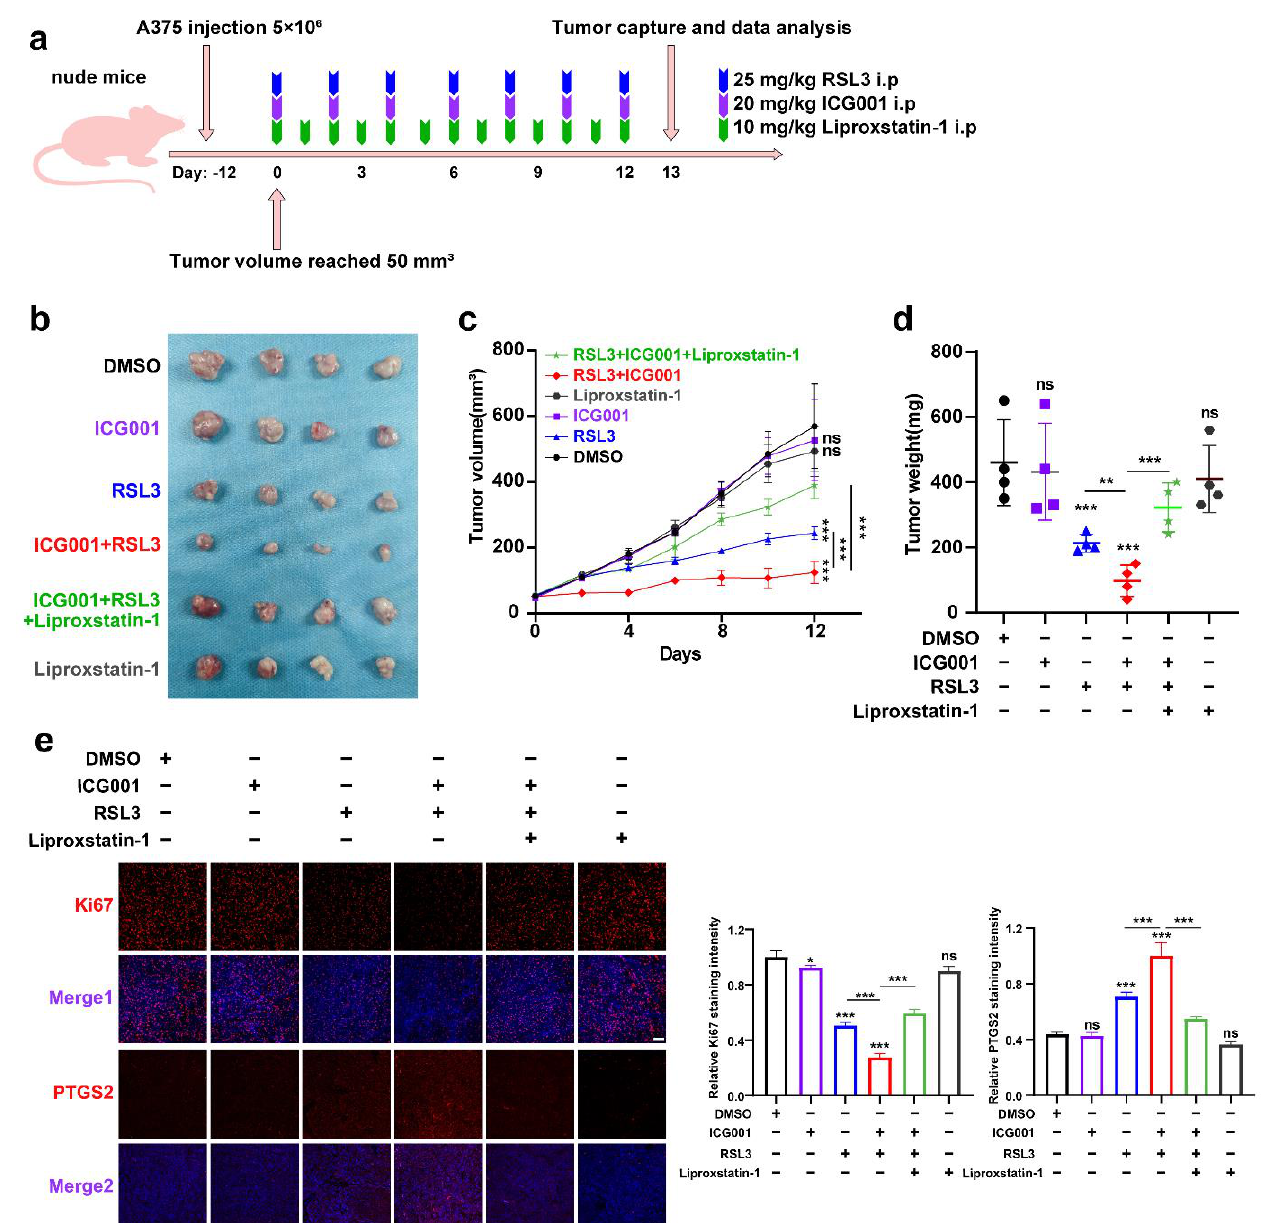
Figure 3. Targeting Wnt/ β -catenin signaling exacerbates melanoma cell ferroptosis in vivo. ( a ) An illustration of the treatment strategy. ( b – d ) Captured images of isolated tumors in xenografted mice receiving the indicated treatments. Tumor volume and weight were calculated for each group, as shown in the right panel. ( e ) IF staining of PTGS2 and Ki67 in isolated xenograft tumors. Scale bar = 50 µ m. Data are presented as mean ± SEM of triplicates. p -value was computed using a two-tailed Student’s t -test. * p < 0.05, ** p < 0.01 and *** p < 0.001. ns,